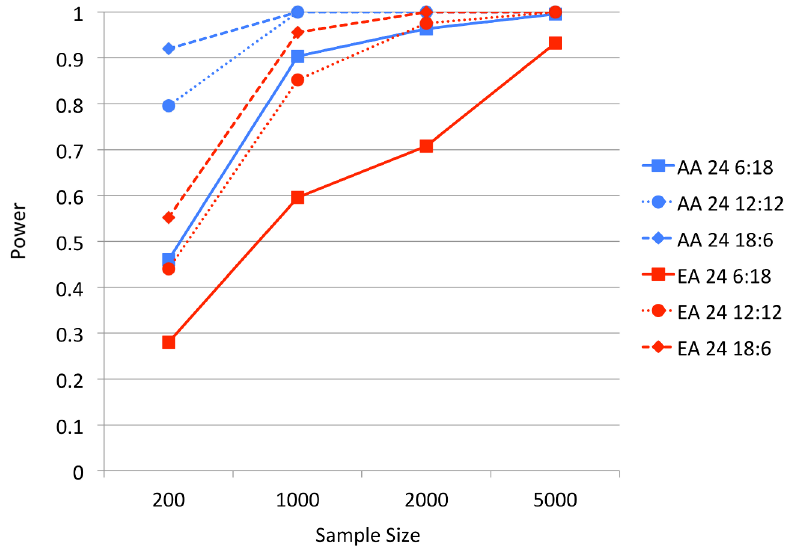
Figure 4. BOMP Power estimates for multiple genes (24) case-control studies. Power estimates for BOMP; each estimate is based on 250 simulated case-control studies ((approximately one-third each from disease etiologies Rare, LowFreq and KeyRegion). The genomic individuals each had 24 genes, the ratio of genes with causal variants to those without causal variants was either 1:3 (6 causal, 18 non-causal), 1:1 (12 causal, 12 non- causal), or 3:1 (18 causal, 6 non-causal). AA=African-American simple bottleneck demographic model. EA=European-American exponential growth demographic model.